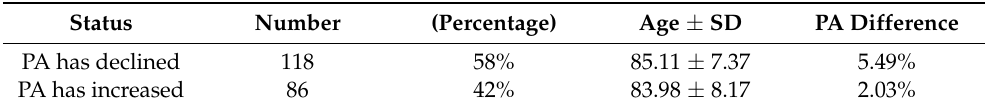
Figure 2. Graph showing activity of all groups before and during the COVID-19 pandemic. The x -axis represents time information with a step of one month; the y -axis represents the activity value. A value of 100% activity corresponds to PA in every minute of the active part of the day (from 7 am to 10 pm). The pre-COVID period is shown in blue; the during-COVID period is shown in red. Overall, the activity before COVID was higher (mean value = 8.894) than after COVID (mean value = 7.885). A total of 58% of participants decreased their PA level between pre-COVID and during-COVID periods, compared to 42% increased their PA. An overview of the values is given in Table 2. Table 2. Number of participants with decreased, unchanged or increased PA when comparing pre-COVID and during-COVID periods.